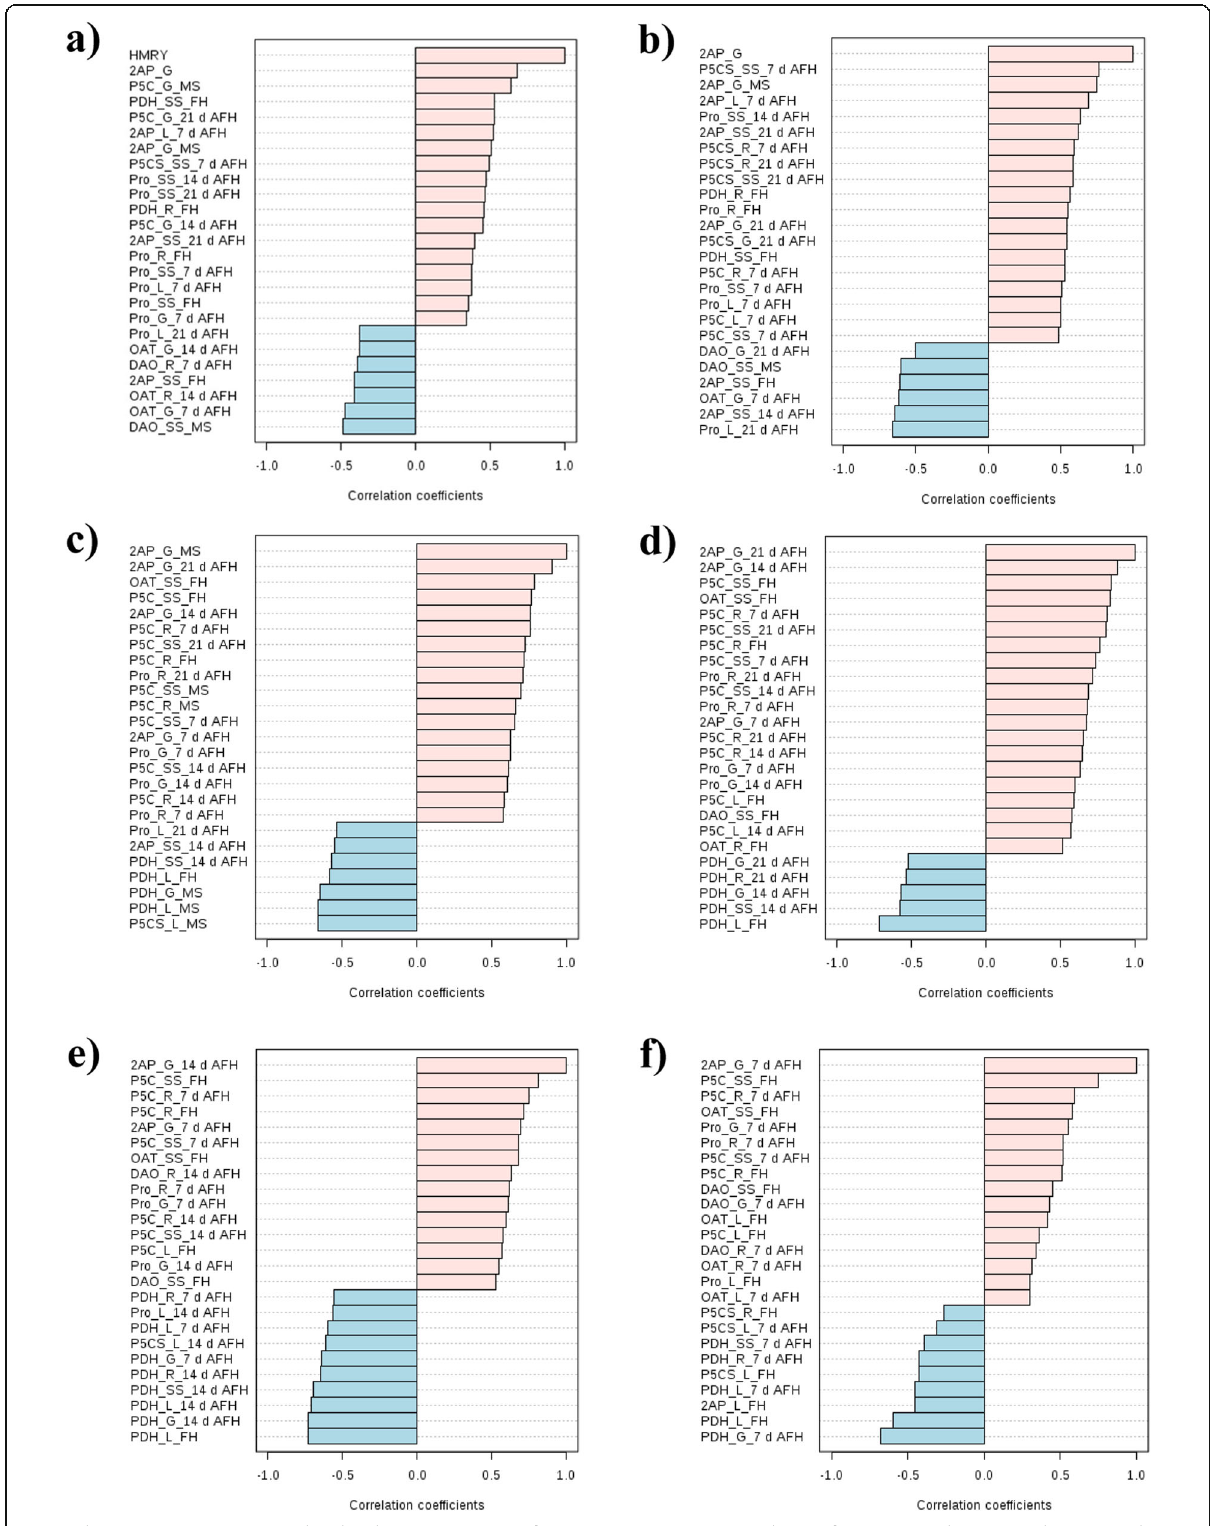
Fig. 2 The top 25 parameters correlated with HMRY( a ), 2AP_G ( b ), 2AP_G_MS( c ), 2AP_G_21 d AFH ( d ), 2AP_G_14 d AFH ( e )and 2AP_G_7 d AFH ( f ). HMRY: Head milled rice yield, 2AP_G: 2AP content in brown rice, 2AP_G_MS: 2AP content in grain at maturity stage, 2AP_G_21 d AFH: 2AP content in grain at 21 d AFH, 2AP_G_14 d AFH: 2AP content in grain at 14 d AFH, and 2AP_G_7 d AFH: 2AP content in grain at 7 d